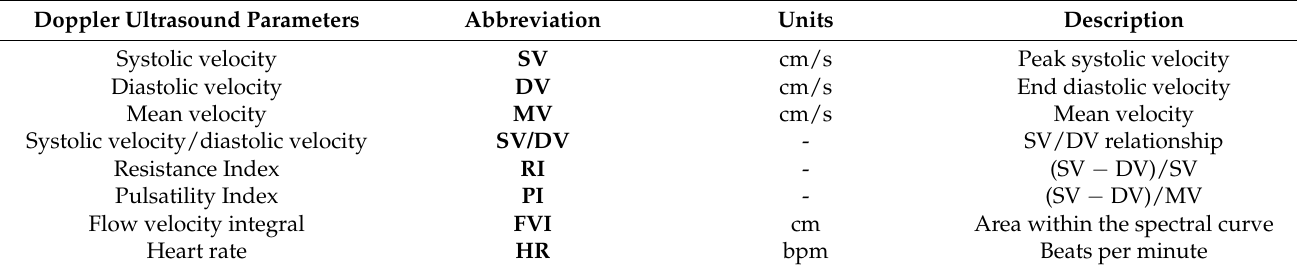
Table 2. Description of Doppler ultrasound